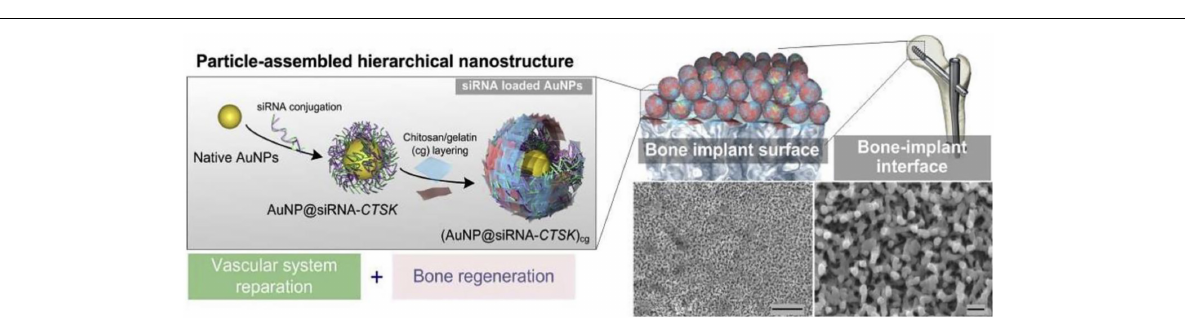
FIGURE 10 | siRNA-decorated nanoparticles were assembled to engineer a hierarchical nanostructured coating on clinically used titanium implants for the synergistic regeneration of skeletal and vascular tissues. Reproduced from Xing et al. (2020) with permission from Elsevier (Copyright